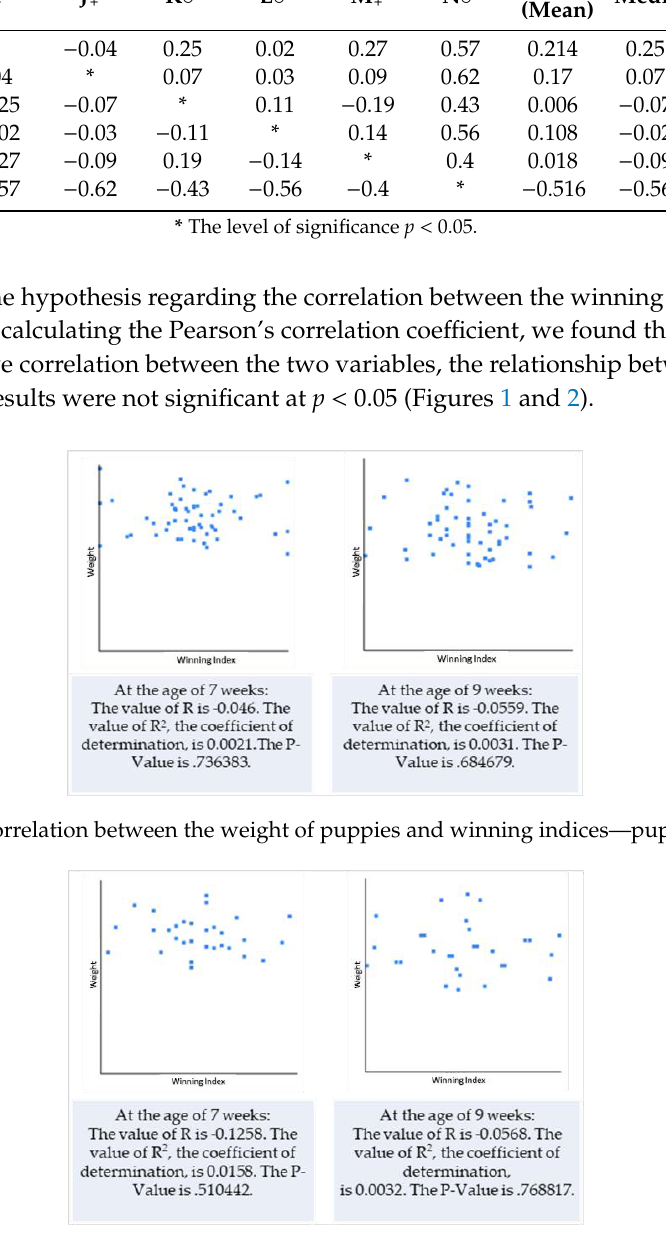
Figure 2. Correlation between the weight of puppies and winning indices—puppy pack 2.